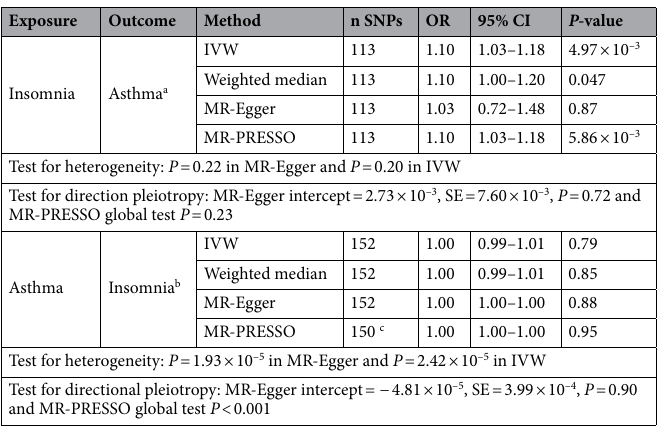
Table 2. Bidirectional Mendelian randomization analyses of insomnia on asthma. a Summary data code: ebi-a- GCST006862. b Summary data code: ukb-a-13. c MR-PRESSO horizontal pleiotropy corrected causal